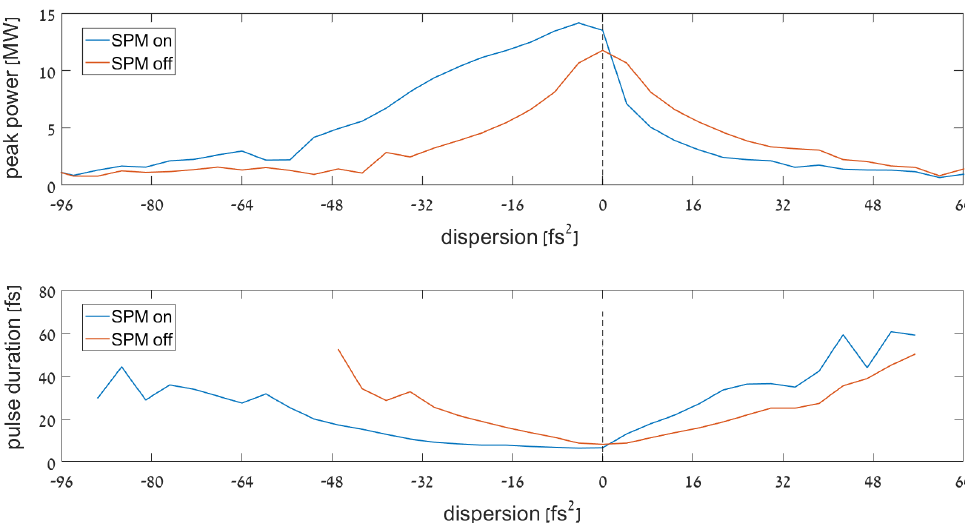
Figure 5. The width and peak power of the pulse as a function of the overall dispersion. The pulse reaches maximum power and minimum width for a specific, nonzero value, due to the dispersion induced by the nonlinear Kerreffect.